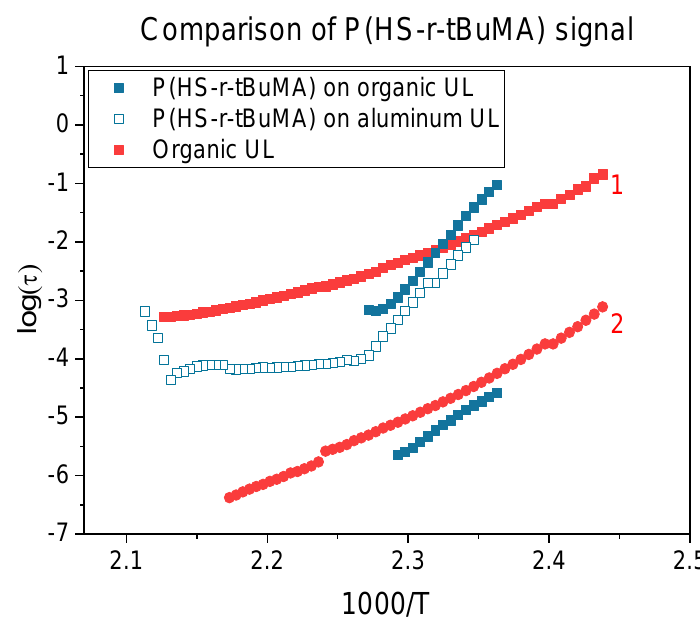
Figure 5. Comparison of DRS signals for the organic underlayer (red) and P(HS- r -tBuMA) on the organic underlayer (blue).